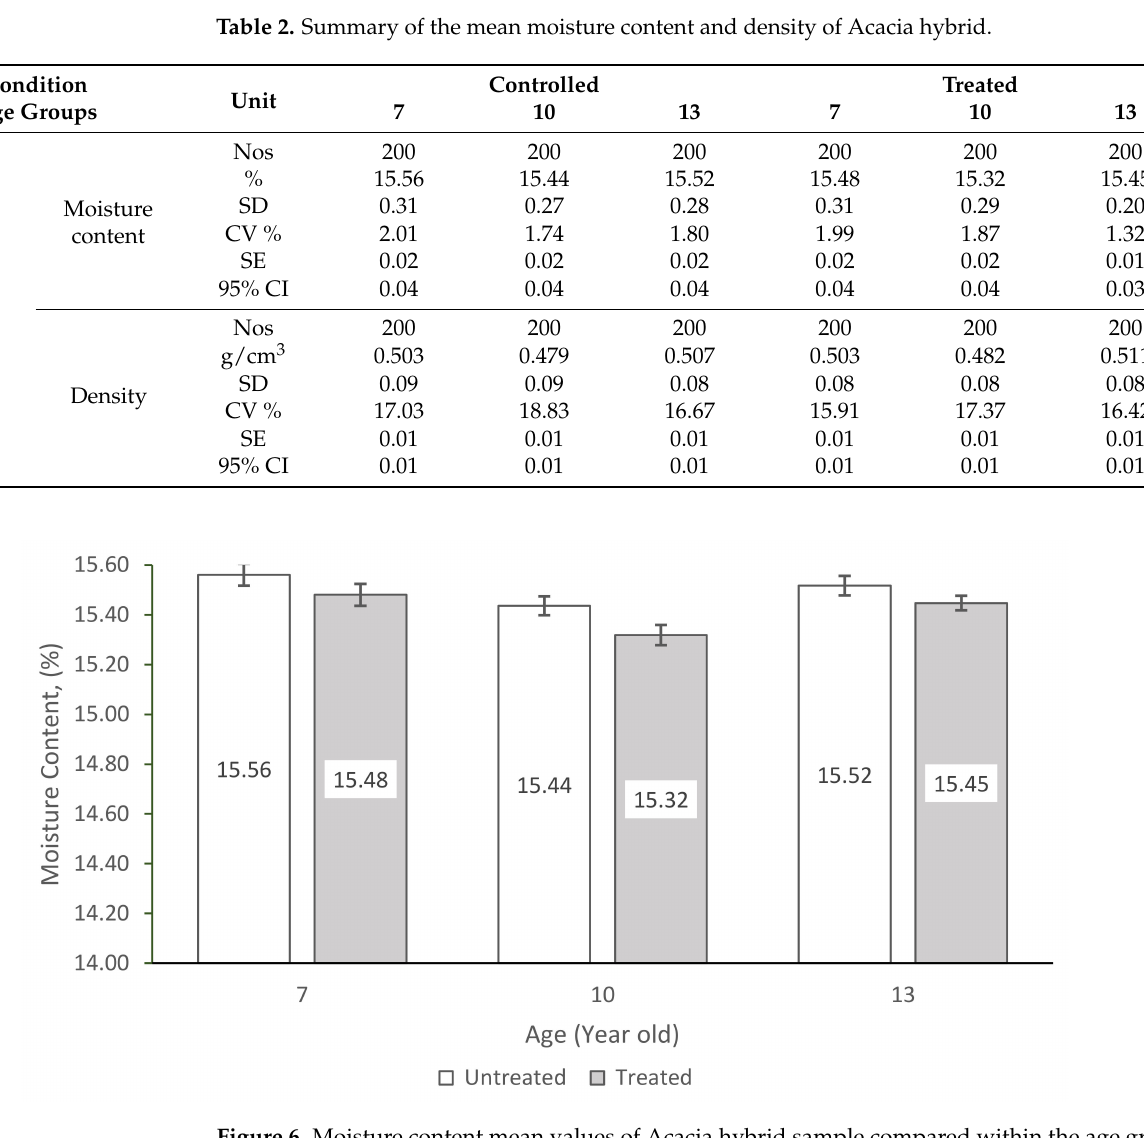
Figure 6. Moisture content mean values of Acacia hybrid sample compared within the age groups, grain direction, and treatment condition at air-dry